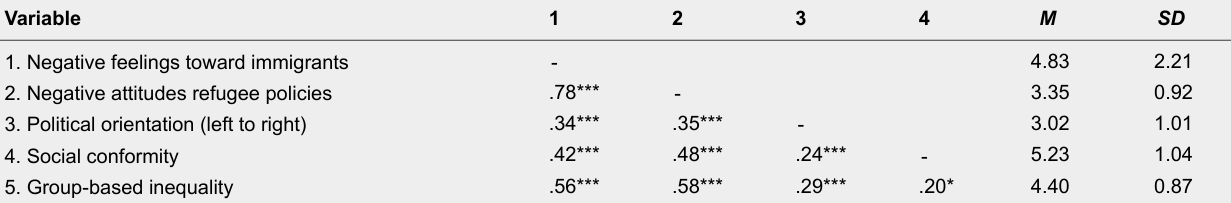
Correlations for the Main Measures (N =